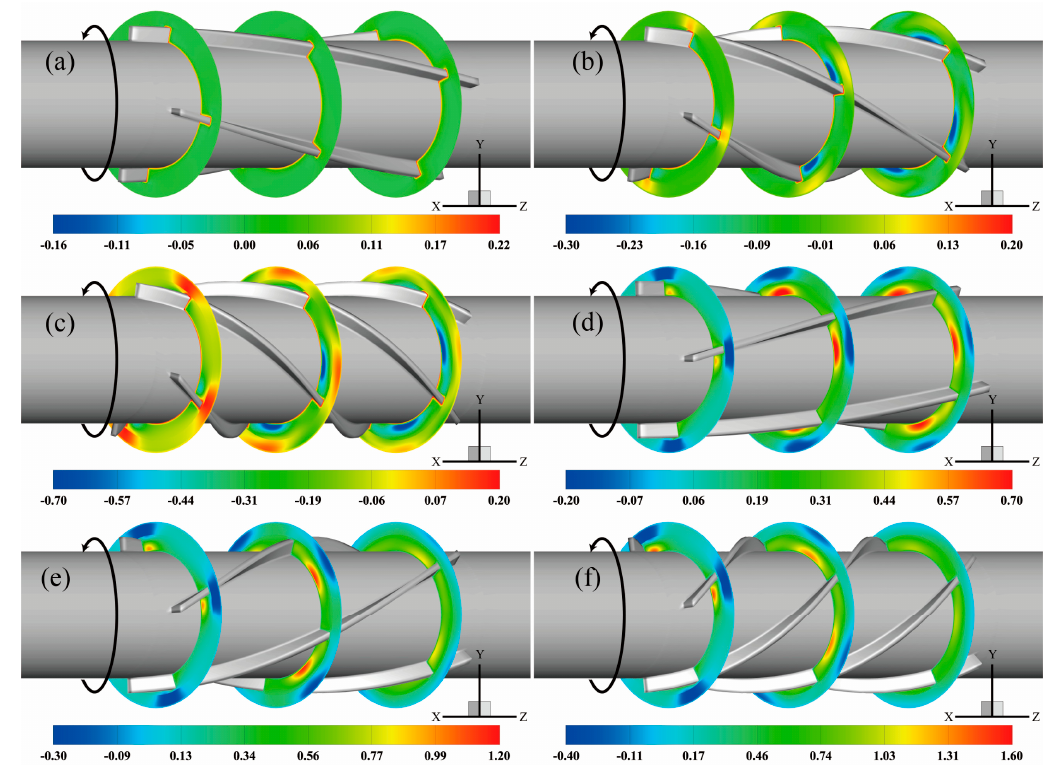
Figure 10. Tangential velocity contours with different helical angles for straight blade at 120 rpm: ( a ) α = 10 ◦ ; ( b ) α = 20 ◦ ; ( c ) α = 30 ◦ ; ( d ) α = − 10 ◦ , ( e ) α = − 20 ◦ , and ( f ) α = − 30 ◦ . Figure 11 shows the tangential velocity distribution curve of the fluid at z = 1.0 m with different helical angles. Near the critical angle of α = 10 ◦ , the tangential velocity of the fluid in this section is approximately zero, because the flow direction of the positive blade is close to the axial flow. When the helical angle is increased to α = 20 ◦ and α = 30 ◦ , the swirl intensity increases, while the rotation direction of swirl flow also changes; the maximum tangential velocity in this section can reach 0.05 m/s and 0.15 m/s. The swirl intensity of the negative blade increases with the decrease of helical angle while the rotation direction keeps the same as the rotation direction of the blades. The swirl flow that is induced by the positive blade at different helical angles at z = 1.0 m cross-section still has considerable tangential kinetic energy, and the maximum tangential velocity is around 0.3 m/s at α = − 30 ◦ . Figure 12 shows the vortex distribution and the stream traces at the end cross-section of the straight blade with different helical angles. It can be seen from α = 10 ◦ , α = 20 ◦ , and α = 30 ◦ , the ability of the positive blade to induce swirl flow is poor, for example, when the helical angle is α = 10 ◦ , the ability to induce the swirl flow is feeble and the central region of the flow channel is almost occupied by the tip leakage vortex. When the helical angle is α = 20 ◦ and α = 30 ◦ , with the increase of the swirl flow intensity, the influence range of the tip leakage vortex gradually becomes smaller, and the swirling effect gradually takes the upper hand. The rotation direction of the swirl flow is changed due to the deflection of the blade to the fluid. This phenomenon results in the swirl flow opposite to the direction of rotation and the tip leakage vortices in the same direction of rotation. The tip leakage vortex can also be seen in negative blades, such as for helical angle α = − 10 ◦ and α = − 20 ◦ , but it cannot be seen at α = − 30 ◦ . With the decrease of the helical angle, the intensity and range of the tip leakage vortex decrease gradually, and finally disappear when α = − 30 ◦ , which is completely absorbed by the mainstream high-intensity swirling